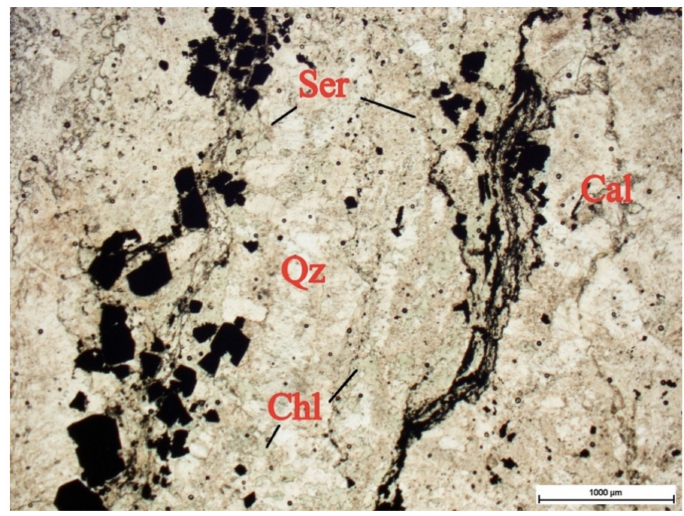
Figure 5. Gold-bearing pyrite-sericite-quartz alteration of the Novogodnee-Monto deposit in thin section of sample NM-19. Pyrite from the same type of rock nearby was used for U-Th-He dating. Qz—quartz; Chl—chlorite; Ser—sericite;